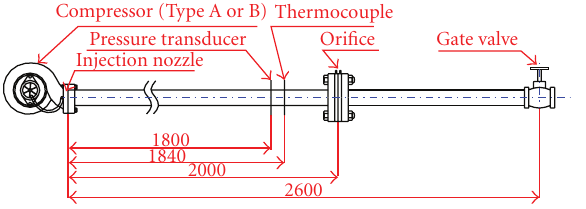
Figure 1: Experimental apparatus (unit: mm).